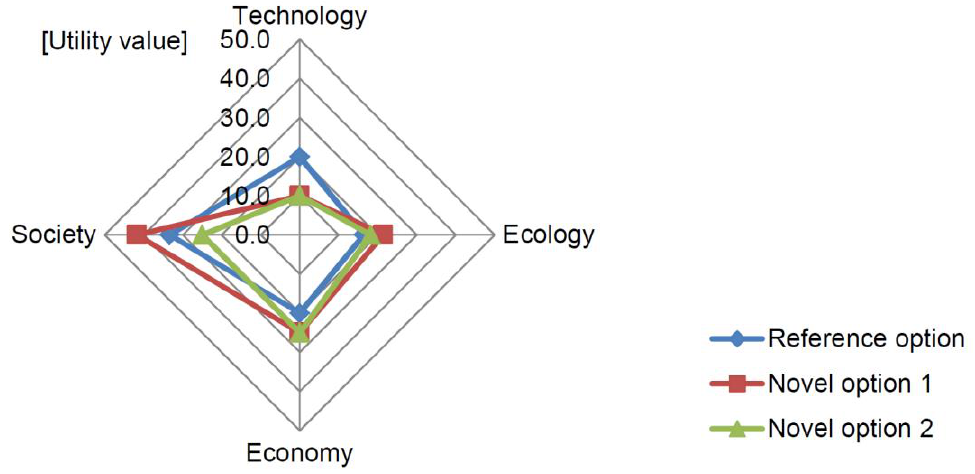
Figure 6. Utility values of water infrastructure options in model area C depending on category (equally weighted).